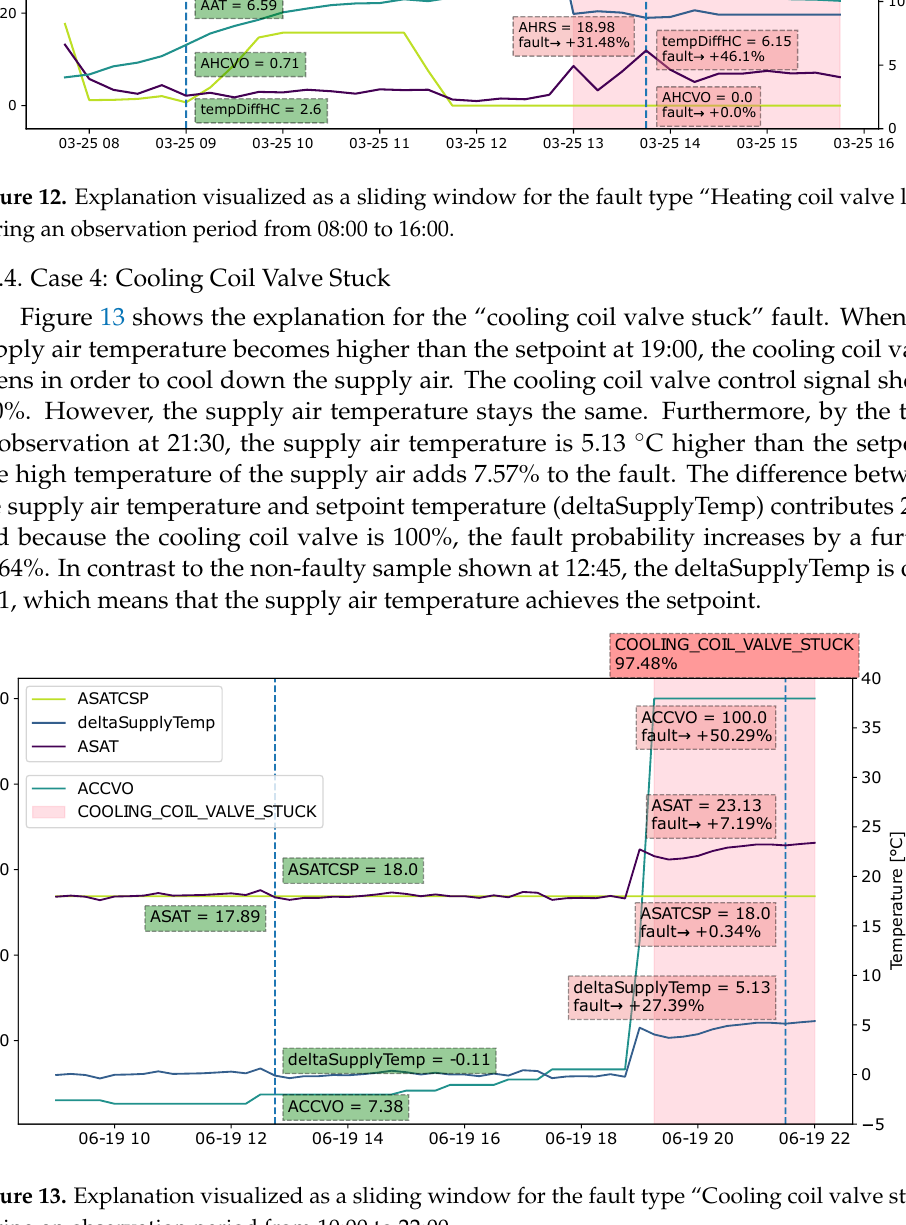
Figure 13. Explanation visualized as a sliding window for the fault type “Cooling coil valve stuck” during an observation period from 10:00 to